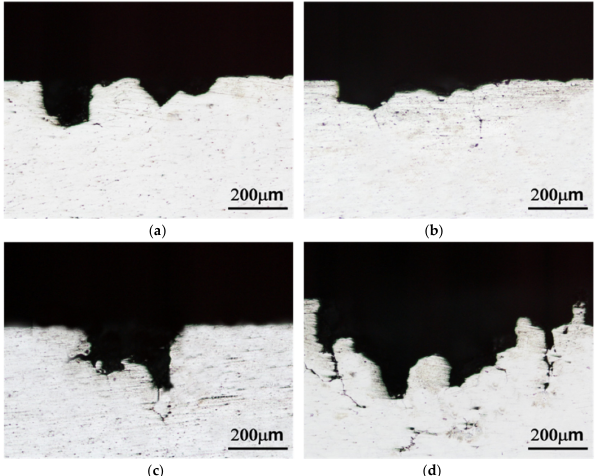
Figure 11. Transverse corroded surface of ( a ) alloy A , ( b ) alloy B , ( c ) alloy C and ( d ) alloy D after sensitization treatment.